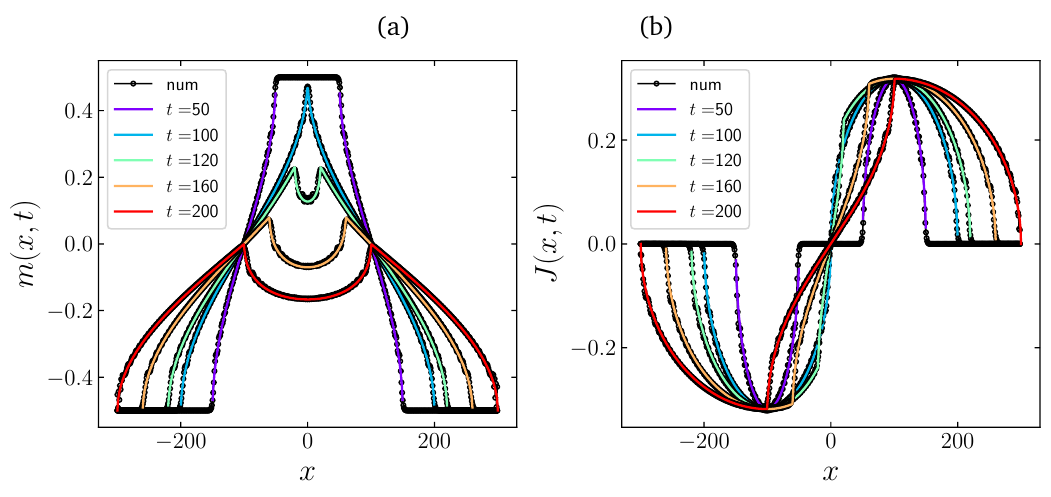
Figure 4: (a) Magnetization and (b) spin current profiles for the non-interacting double domain wall melting problem. The different curves show the behavior of the analytic solutions (21)-(22) at different times while the symbols are obtained with exact numerical calculations on a lattice of size L = 600 and (cid:96) = 100. The matching of the profiles with the numerics is extremely